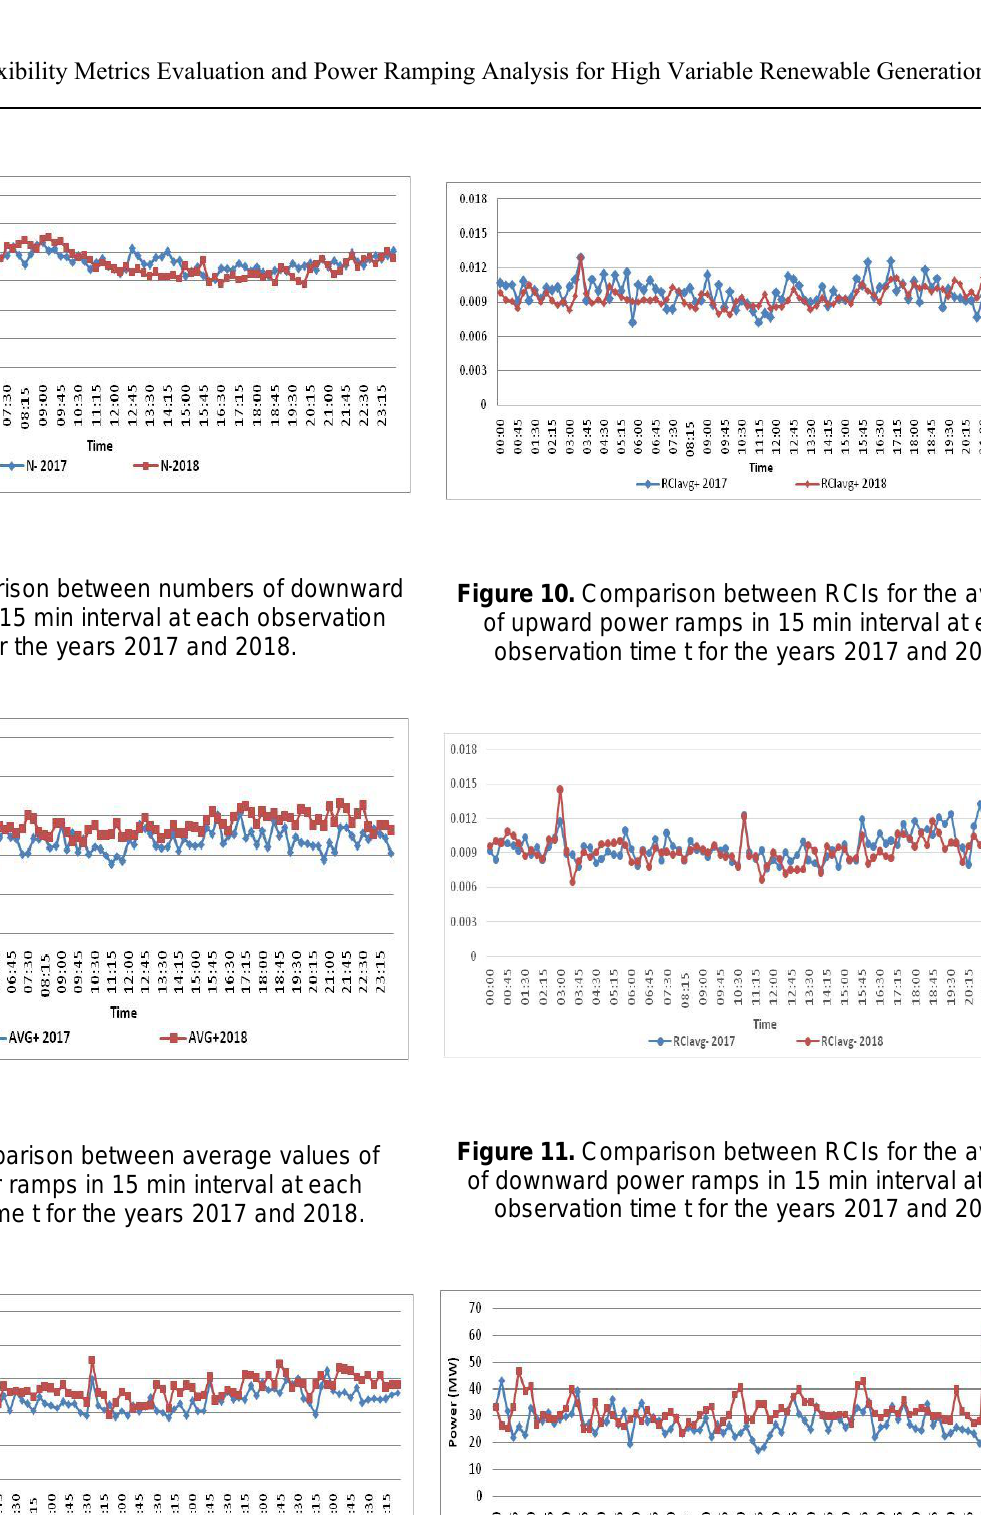
Figure 9. Comparison between average values of downward power ramps in 15 min interval at each observation time t for the years 2017 and 2018.